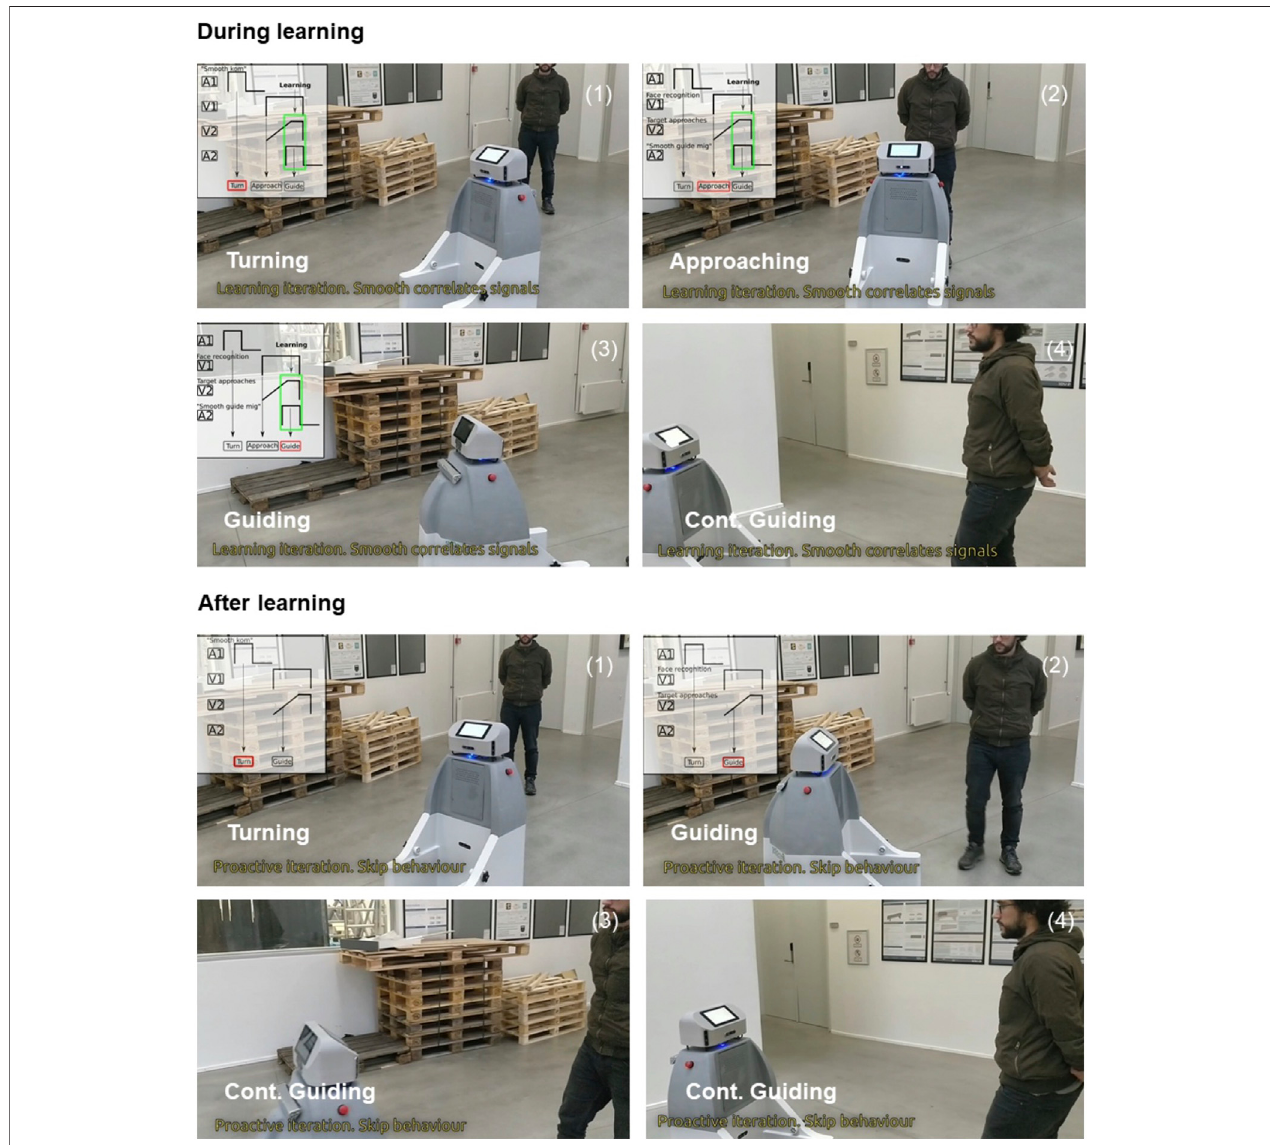
FIGURE 11 | Snapshots of robot learning transitions. In the learning phase, the SMOOTH-robot performed three sensor-driven behaviors sequentially: turning drivenbyA1(audiofeedback),approachingdrivenbyV1(visualfeedback),andguidingdrivenbyA2(audiofeedback).Simultaneously,inthisphase,theSMOOTH-robot also learnedthecorrelation ofavisual-based(earlier) predictivesignal(V1)when seeingthehumanwalkingtoitand anaudio-based(later)re fl exsignal(A2)whenhearing the command asking it to guide. After learning, it can realize the human motion (walking toward it) as the human intention to walk to a destination without naming it explicitly. As a consequence, it switched to its guiding behavior to guide the